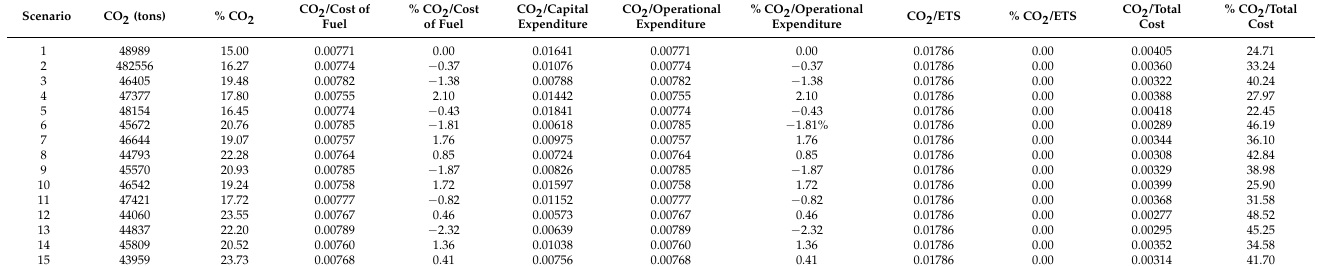
Table 8. Absolute values and percentages when compared to the respective values from the reference scenario for all scenarios, starting from carbon emissions in tons, carbon emissions per cost of fuel consumption, carbon emissions per capital expenditure, carbon emissions per operational expenditure, carbon emissions per cost of the defined emissions trade system and carbon emissions per total cost.